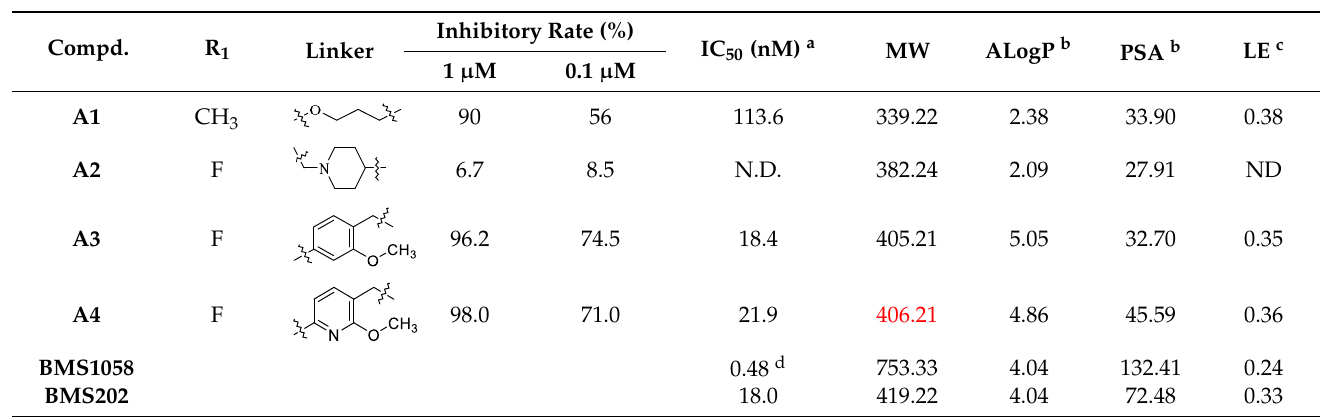
Table 1. Activities of compounds A1 – A4 in inhibition of the PD-1/PD-L1 interaction.